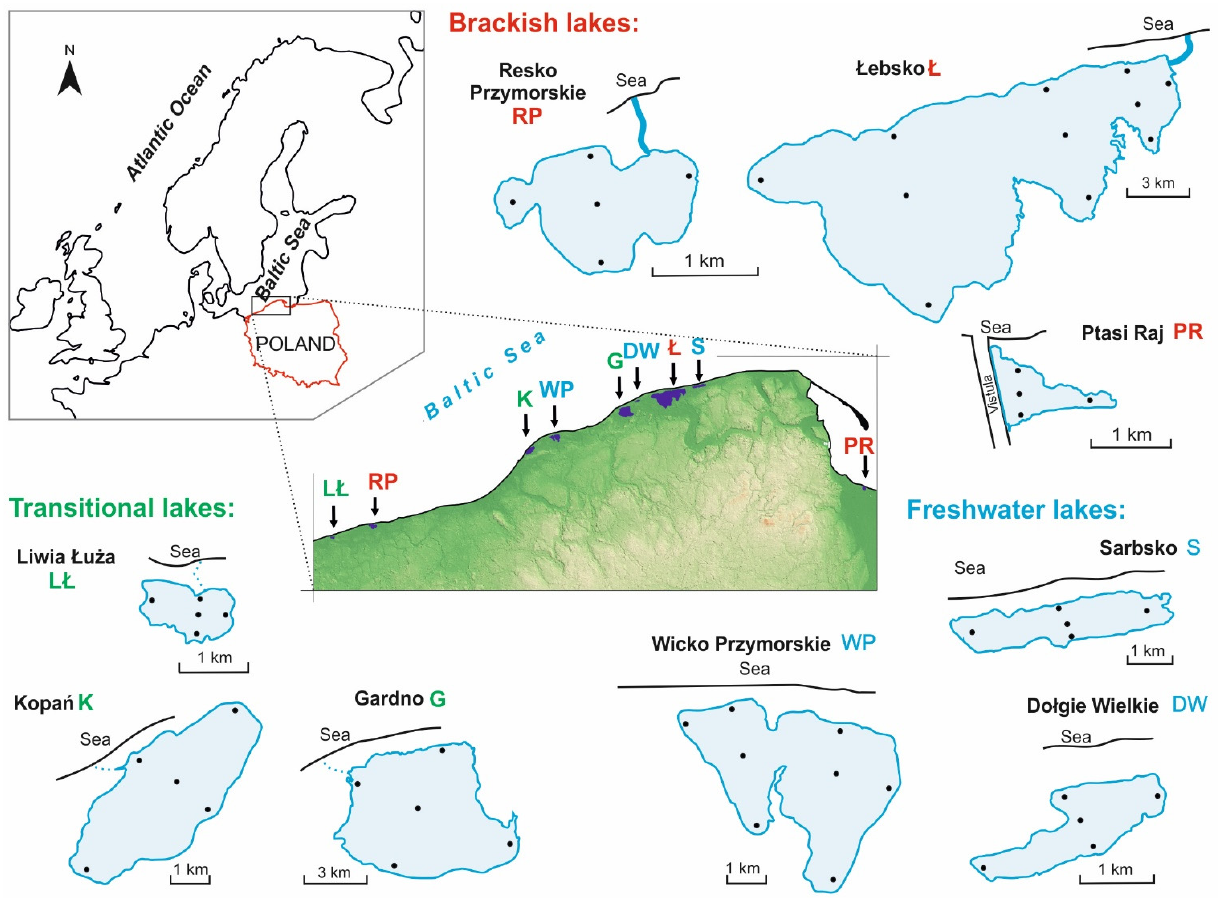
Figure 1. Location of studied coastal lakes along the Southern Baltic Sea. Black dots indicate sam- pling sites.